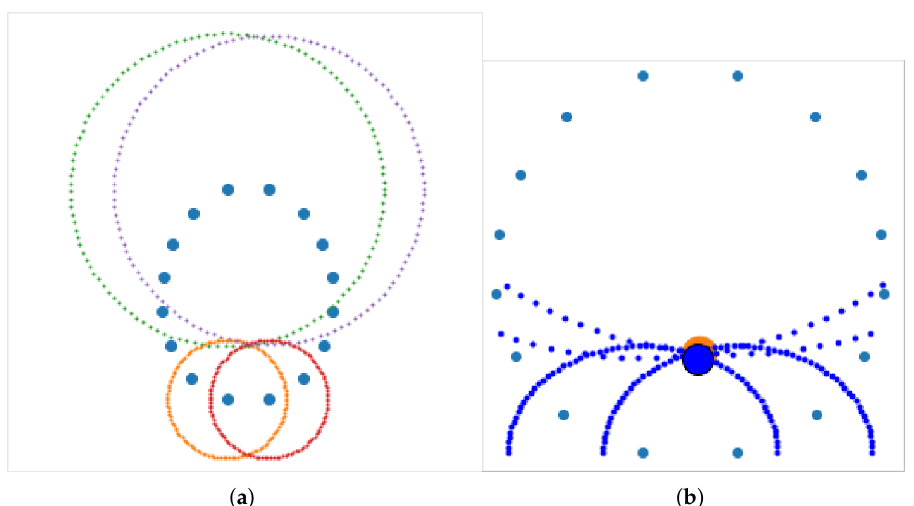
Figure 6. ( a ) Intersection result of circular trajectories based on the predicted distance d 0 , d 7 , d 8 , d 15 , and ( b ) comparison of ground truth (blue area) and predicted position (orange area).